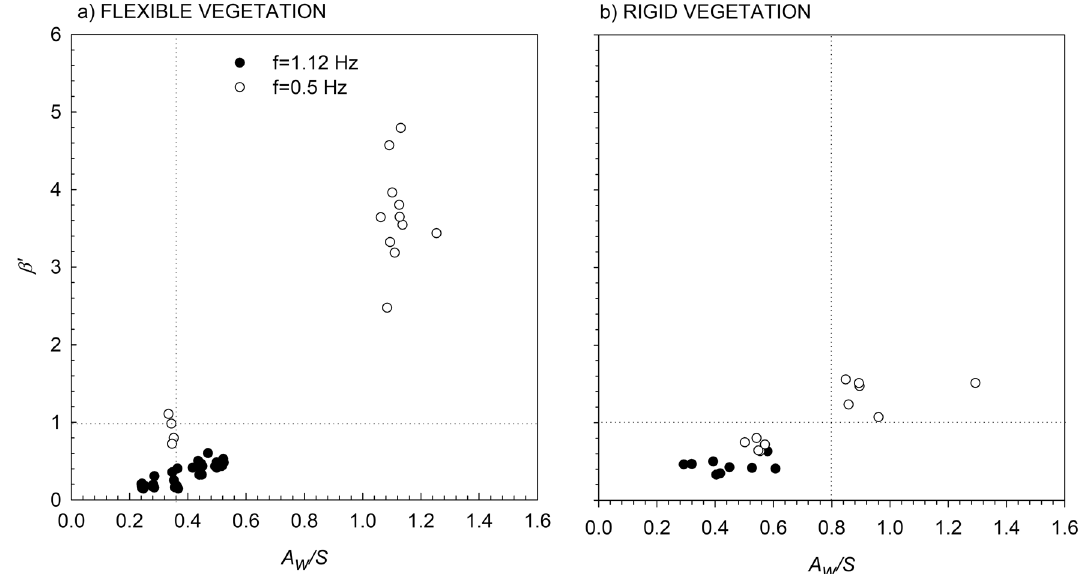
Figure 3. Vertical TKE attenuation, β ′ , for the ( a ) flexible vegetation model and ( b ) rigid vegetation model. Unfilled circles correspond to f = 0.5 Hz, and solid black circles correspond to f = 1.12 Hz. The vertical dashed lines indicate the threshold of A w /S for each type of plant, and the horizontal dashed line represents the y-axis value of β ′ =